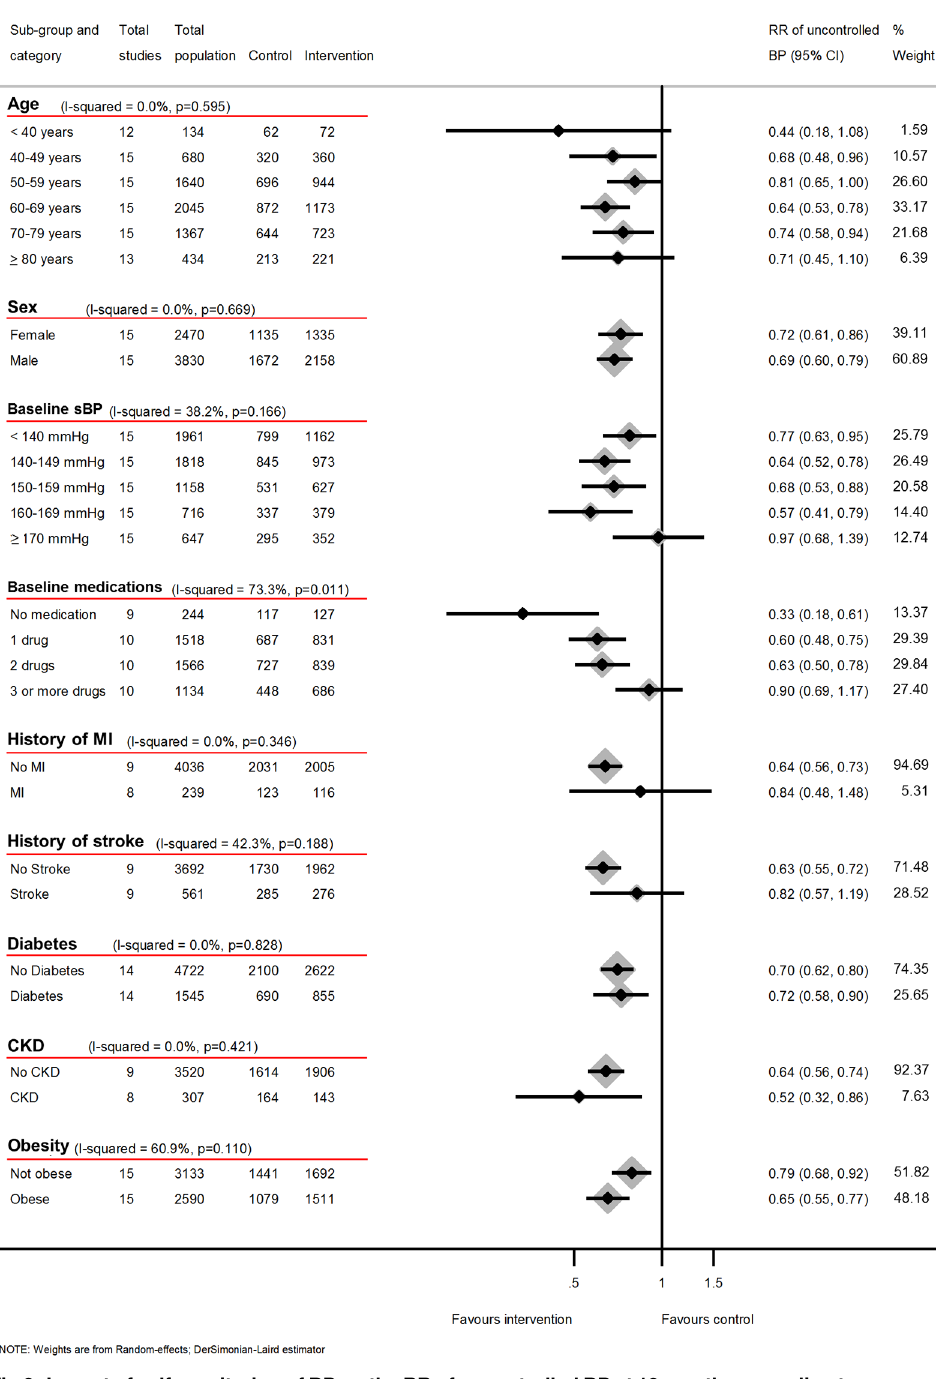
Fig 8. Impact of self-monitoring of BP on the RR of uncontrolled BP at 12 months according to prespecified subgroups (15 studies). Obesity definedas BMI (cid:21) 30 kg/m 2 . RR of uncontrolledBP at 12 months adjustedfor age, sex, baselineclinic BP, level of intervention,and studies contributing patient data. Abbreviations: BMI, body mass index; BP, blood pressure; CKD, chronickidney disease;MI, myocardial infarction; RR, risk ratio; sBP, systolic blood pressure.